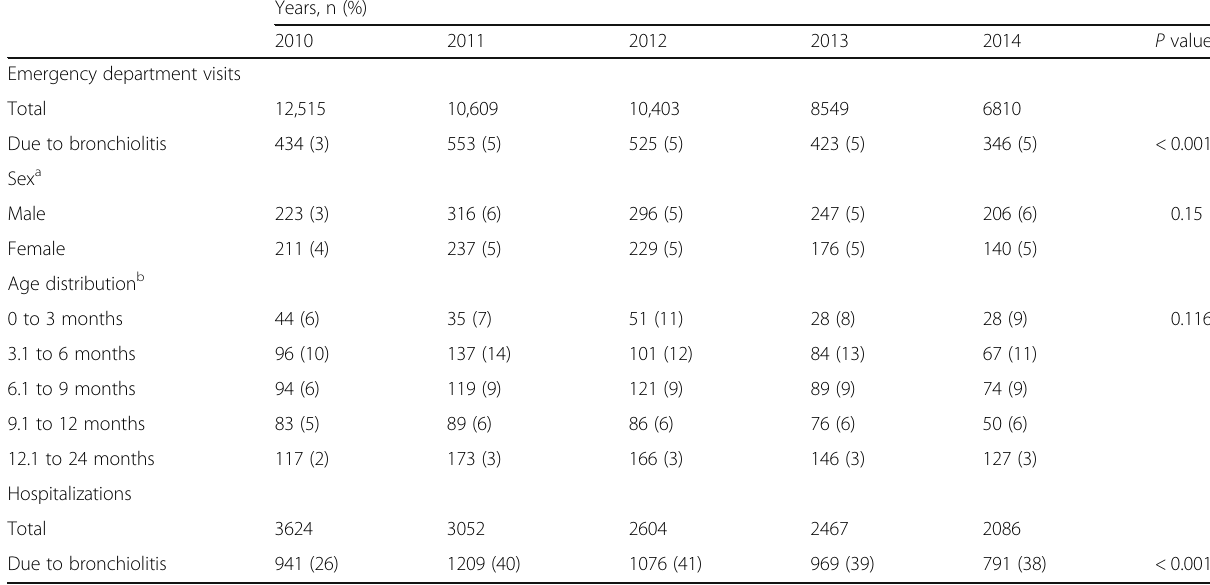
Table 1 Distribution of emergency department visits and hospitalizations due to bronchiolitis, 2010 –